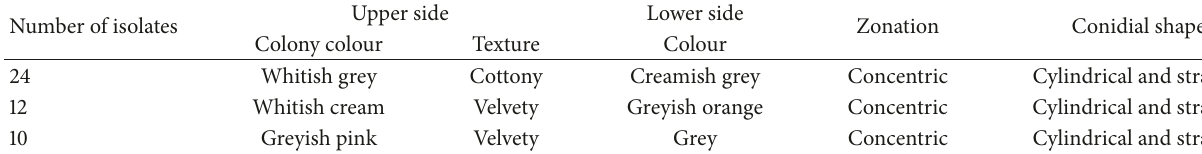
Table 1: Cultural and morphological characteristics of the Colletotrichum gloeosporioides on PDA.